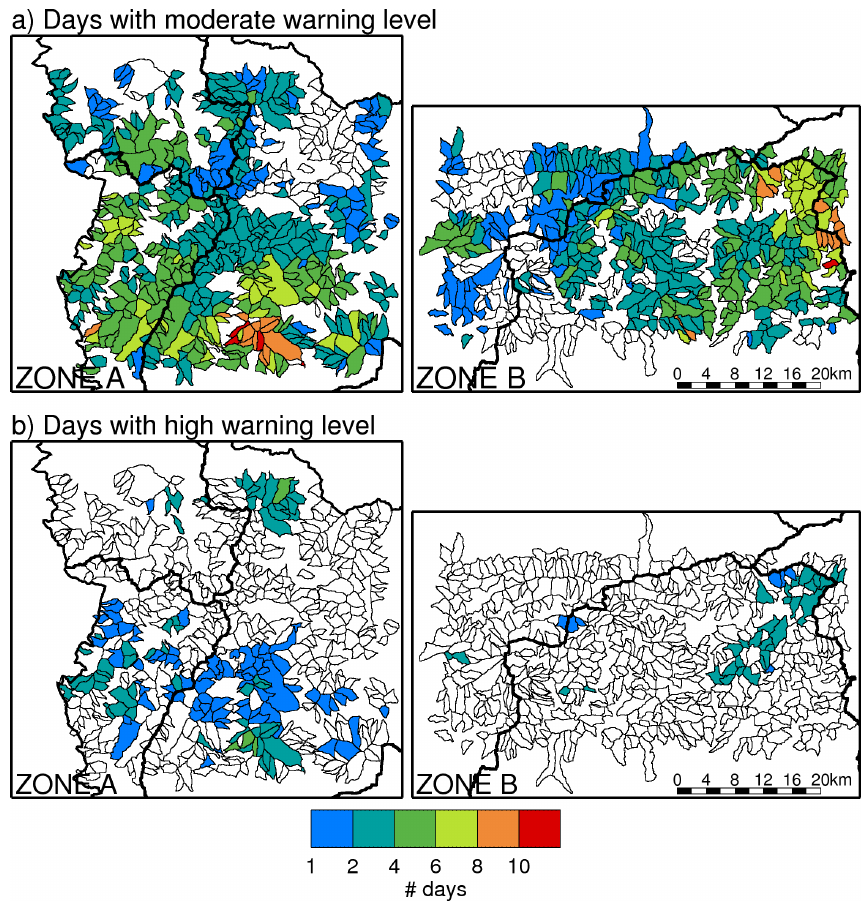
Figure 11. Number of days for which the warning level in the period 1 May to 31 October 2010 was (a) “moderate” and (b) “high”.